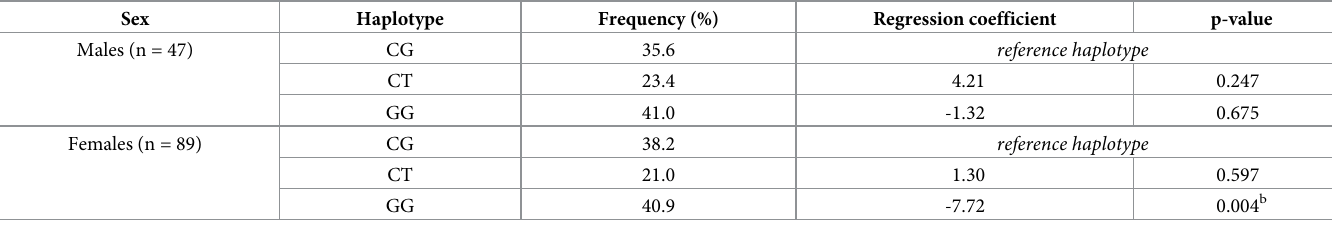
a Block number is from LD plot (Fig 1). Association analyses in were performed considering covariates (age, ethnicity, sickle cell type). b Significant p-values (p �